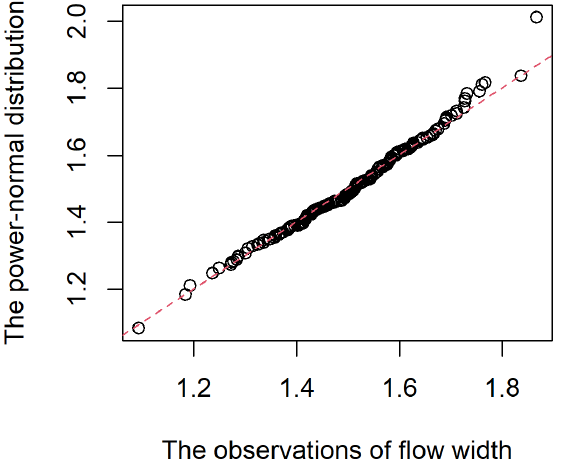
Figure 3. The histogram of the flow width data in Example 1. Stage 2: The impact of the sample size on the quality of the confidence interval of C L :